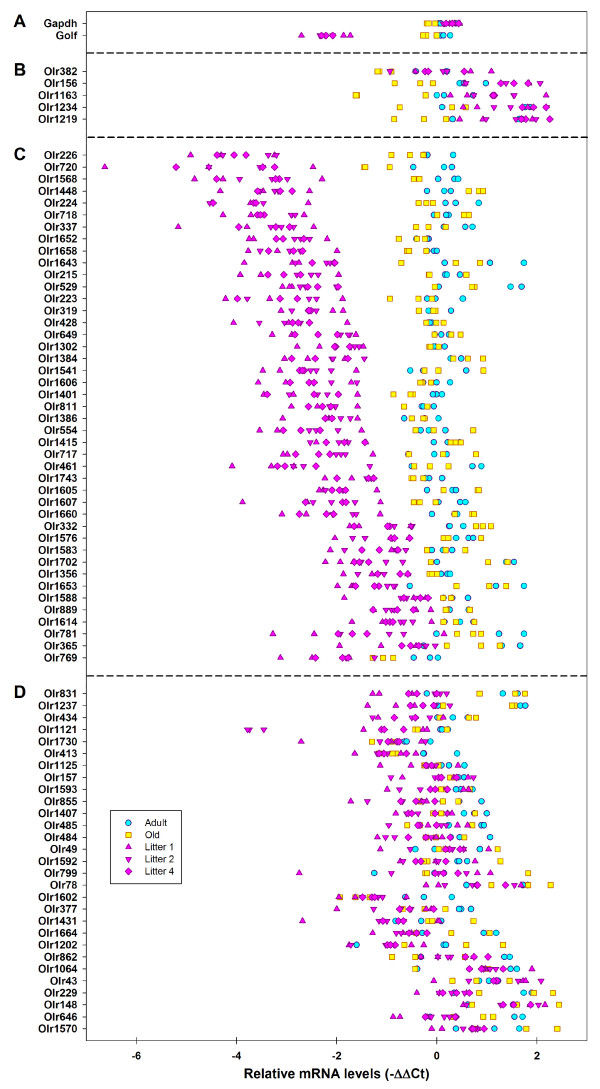
Relative expression of a subset of 77 OR genes at three different ages. RTqPCR was performed for 77 OR mRNAs, with olfactory epithelium mRNA prepared from 3 adult rats, 3 old rats and 9 newborn rats from three litters (L1, L2 and L4) used as a template (i.e. 15 samples, each analyzed in triplicate). Results are expressed as ΔΔCt values with Hprt taken as a reference (x axis). Gene names are distributed into four sectors, from top to bottom: (A) Gαolf, which is clearly less strongly expressed at birth and Gapdh, which is expressed at similar levels in all age groups, (B) 5 OR genes more strongly expressed at birth than later in life, (C) 43 OR genes far less strongly expressed at birth than at other ages and (D) 29 genes expressed to a similar extent at birth and at other ages or only slightly less strongly expressed at birth.